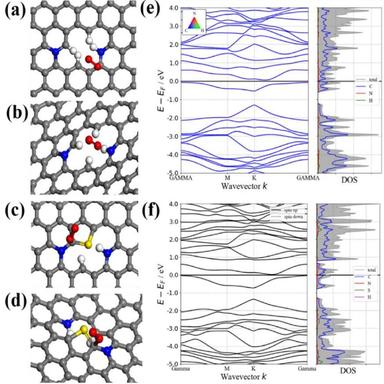
O2 adsorption schematic diagram of CN (aeb) and CNS (ced) catalysts (Gray balls represent C atoms, red balls represent O atoms, blue balls represent N, yellow balls represent S atoms, and white balls represent H atoms.); Energy band and density of states for (e) CN and (f) CNS. (A colour version of this figure can be viewed online.)